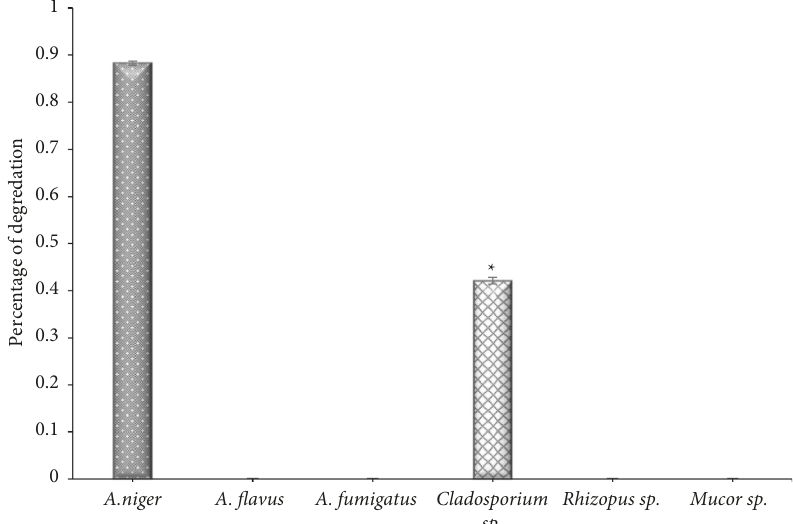
Figure 5: The activity of pectinase of endophytic fungi isolated from Ziziphus spina leaves on solid medium. ∗ Significant difference with all other groups at P < 0 .